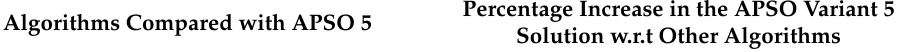
Table 8. Comparison of the APSO 5 solution with other algorithms’ solutions regarding percentage increase for the 100-PHEV dataset.